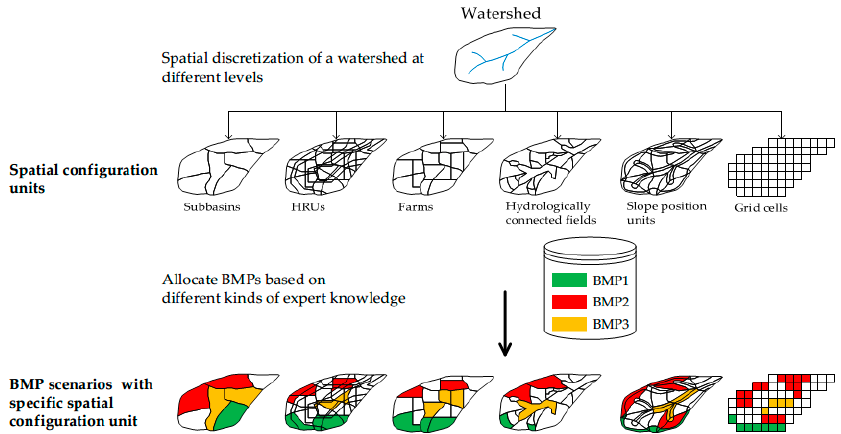
Figure 1. Schematic diagram of spatial discretization of a watershed at different levels (such as sub-basins, hydrologic response units (HRUs), farms, hydrologically connected fields, slope position units, and grid cells) and the corresponding best management practice (BMP) scenario examples after allocating multiple types of BMPs based on different kinds of expert knowledge.